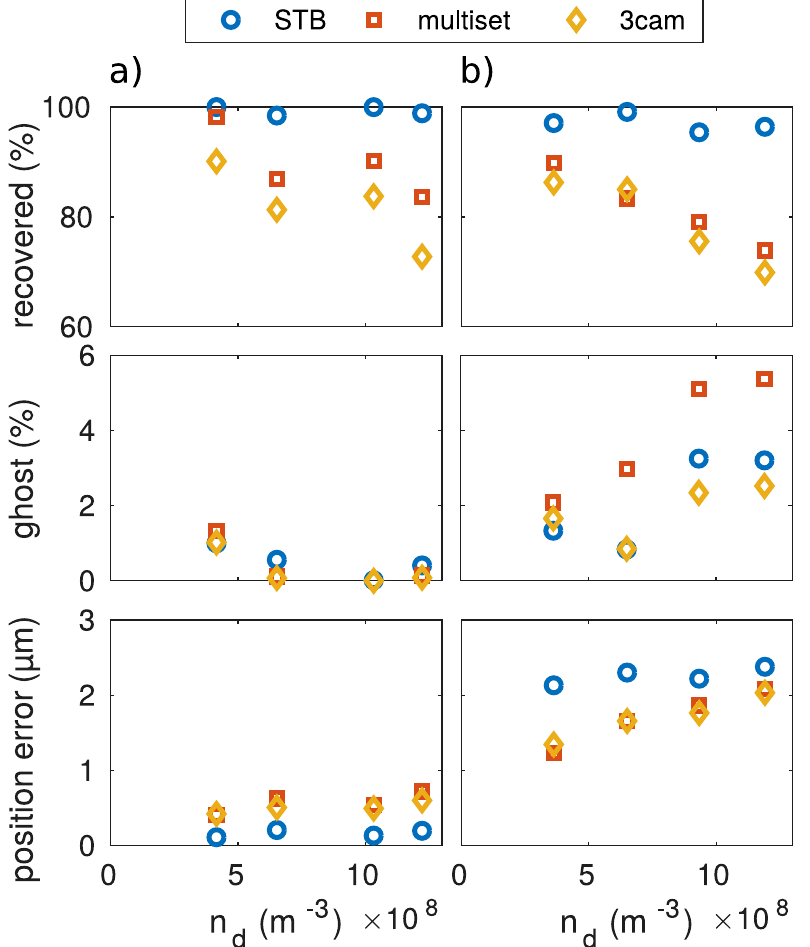
Figure 6. Comparision of different camera orientations. The results obtained with the wide-angled camera setup are shown in column ( a ) and the results from the narrow-angled setup are shown in column ( b